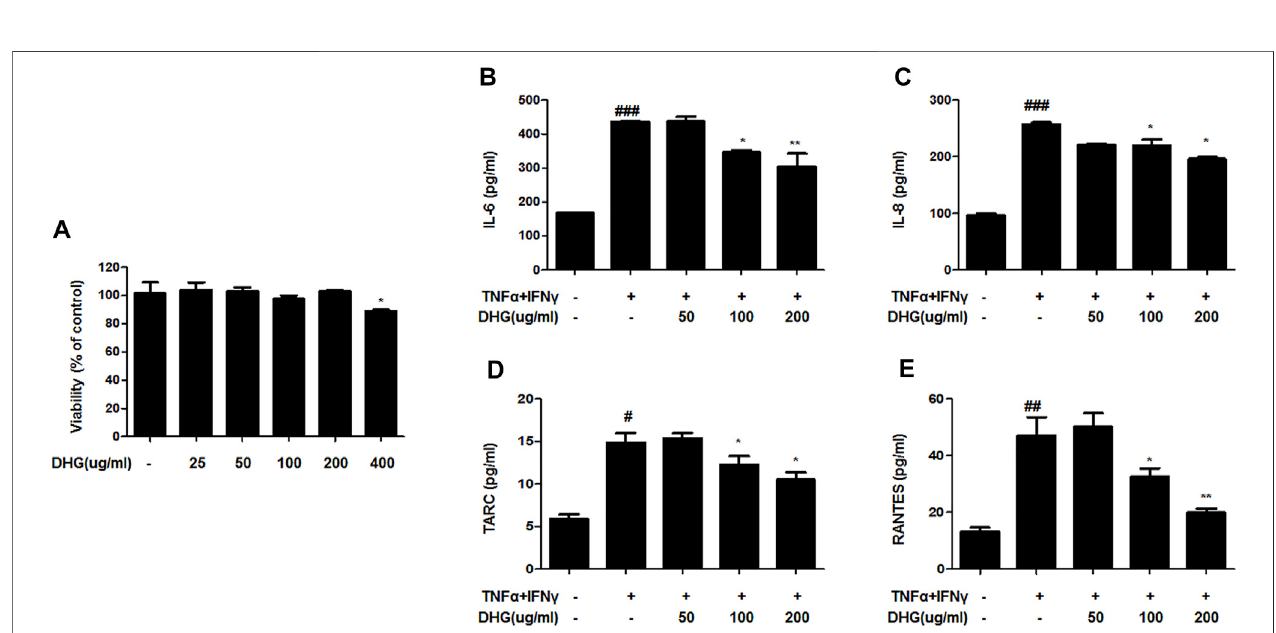
FIGURE 7 | The effects of DHG on production of pro-in fl ammatory and chemokines in TNF- α /IFN- γ – induced HaCaT cells. The cytotoxicity of DHG on HaCaT cell (A) .TheproductionofIL-6 (B) ,IL-8 (C) ,TARC (D) ,RANTES (E) ,weremeasuredbyusingtheculturesupernatantofTNF- α /IFN- γ – stimulatedHaCaTcells.Thecellswere pretreated withthe indicatedconcentrations ofDHG for3 h and thenstimulatedwithTNF- α /IFN- γ (each 10 ng/ml) for24 h. Dataare represented asmean±SD ofthree independent experiments. *P < 0.05, **P < 0.01. compared with the TNF- α /IFN- γ -treated group.